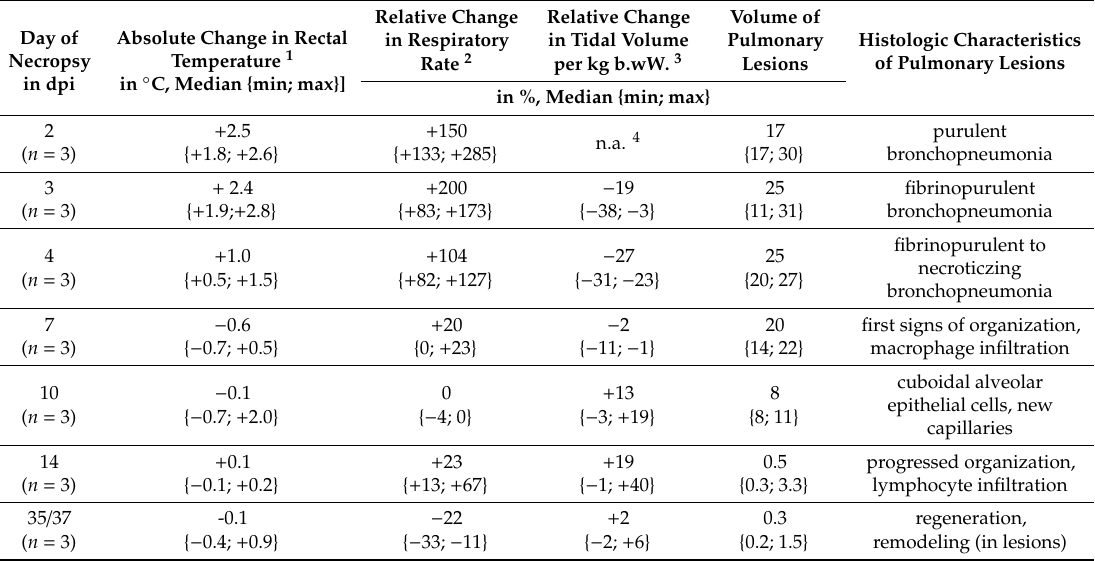
Table 1. Clinical data, respiratory function, volume and characteristics of pulmonary lesions.